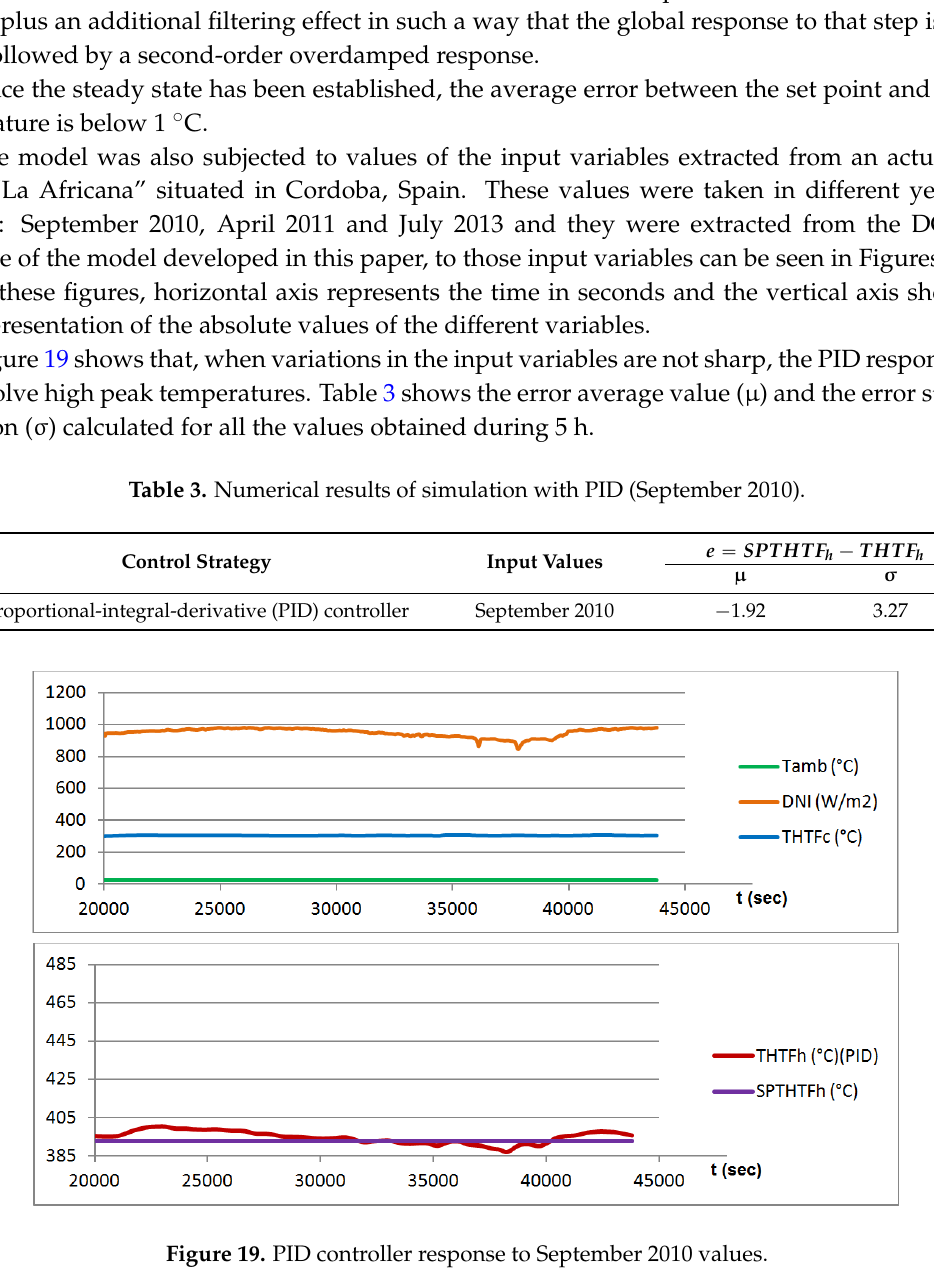
Figure 20. PID controller response to April 2011 values.